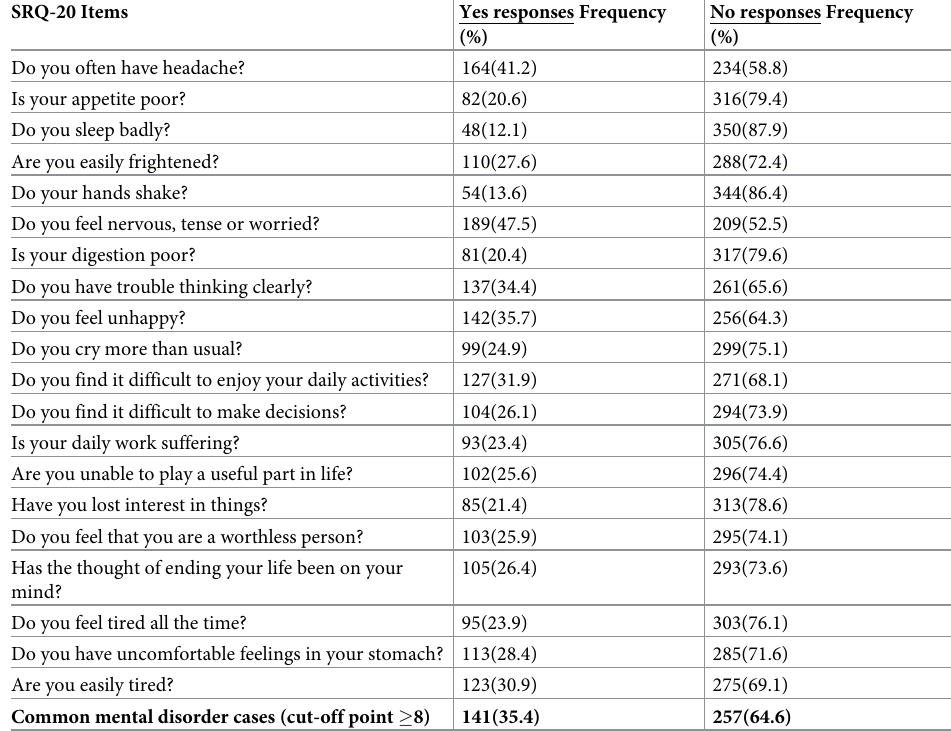
Table 3. Distribution of SRQ-20 symptoms among people living with epilepsy attending at government health institutions in Bahir Dar City, 2017 (n = 398). SRQ-20